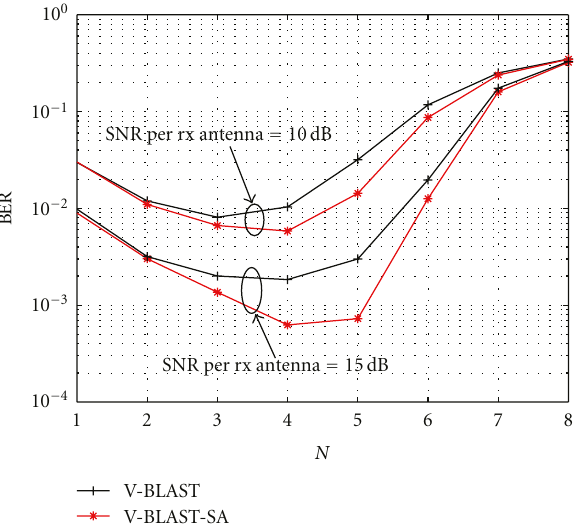
Figure 10: BER versus N for V-BLAST, V-BLAST-SA for SNR per rx antenna = 10dB and 15 dB, N = M , N t = 7, QPSK.